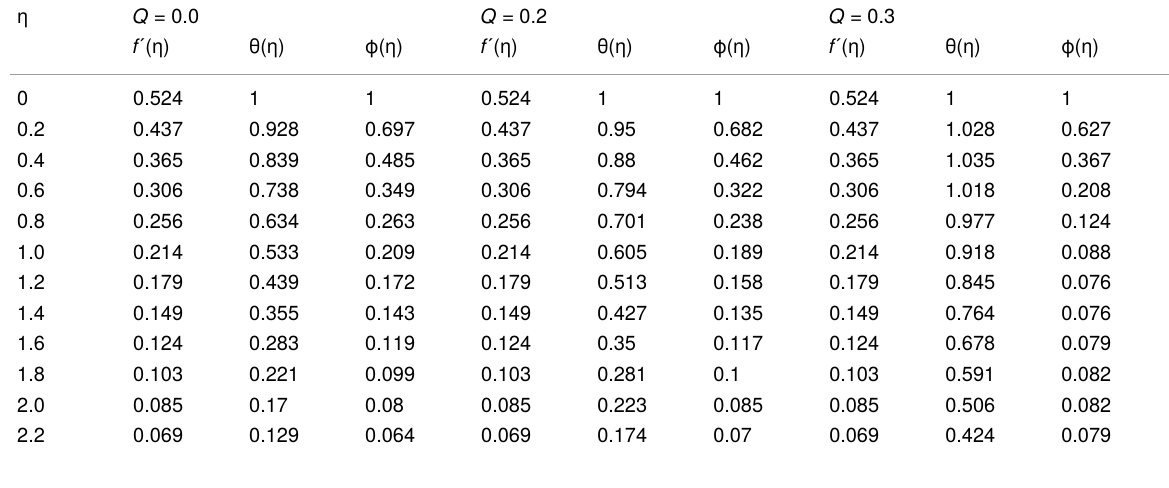
Table 3: Computation of streamwise velocity, temperature and concentration profiles for different values of the heat generation/absorption coefficient, Q . η Q =